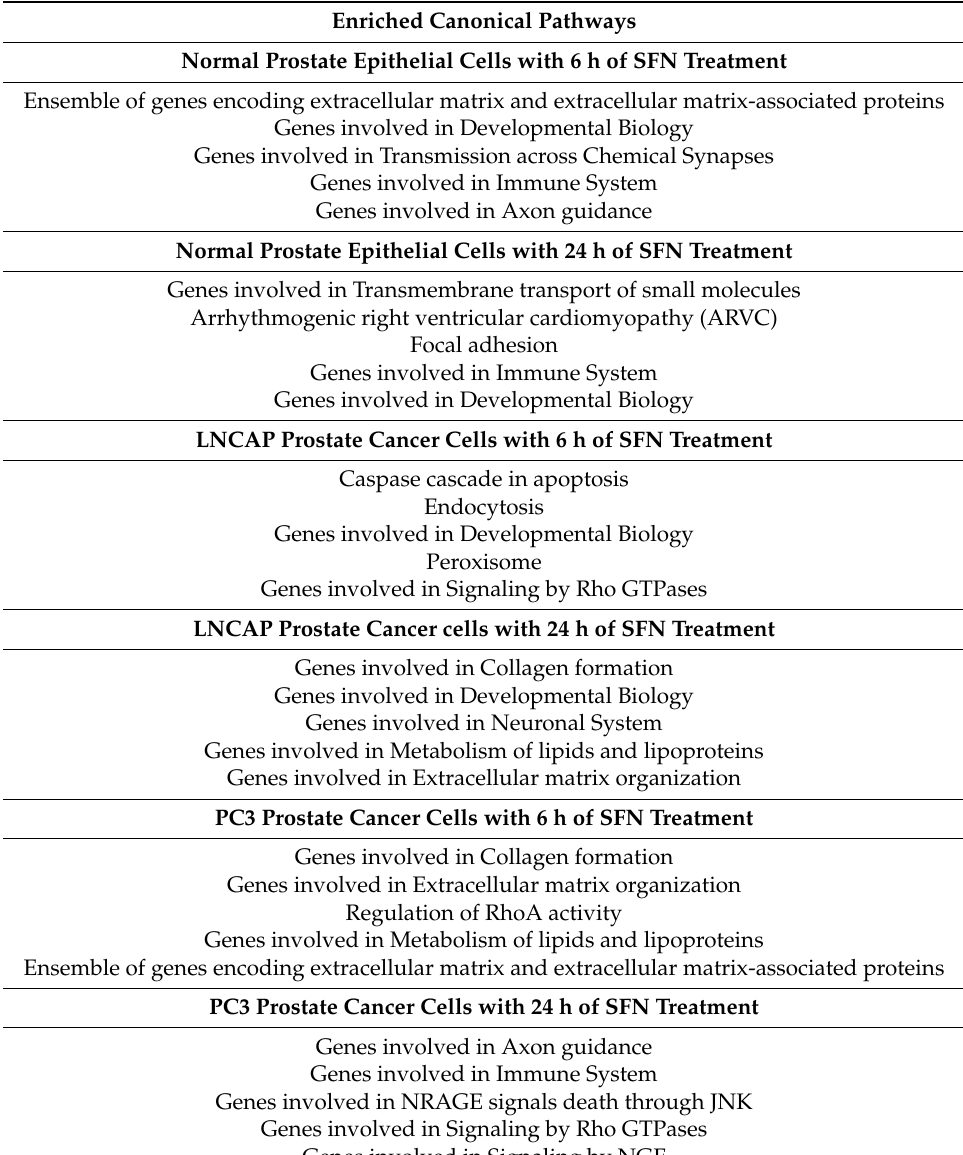
Table 6. Top 5 enriched canonical pathways for the genes with differentially expressed introns after SFN